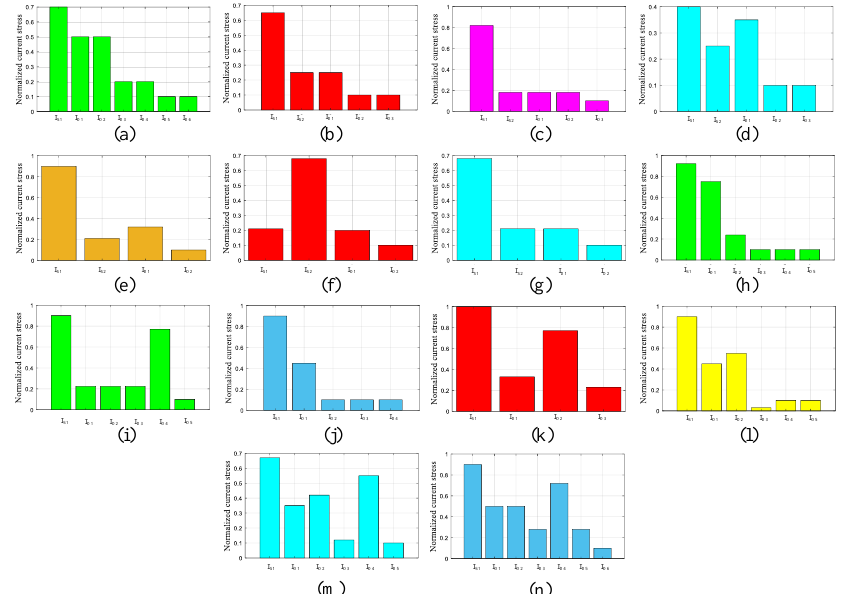
Figure 13. Comparison of the current stresses of the semiconductors and duty cycle, which provides a 10-times voltage gain: ( a ) proposed converter, ( b ) introduced topology in [18], ( c ) introduced topology in [19], ( d ) introduced topology in [20], ( e ) introduced topology in [21], ( f ) introduced topology in [22], ( g ) introduced topology in [23], ( h ) introduced topology in [24], ( i ) introduced topology in [25], ( j ) introduced topology in [26], ( k ) introduced topology in [27], ( l ) introduced topology in [28], ( m ) introduced topology in [29], ( n ) introduced topology in